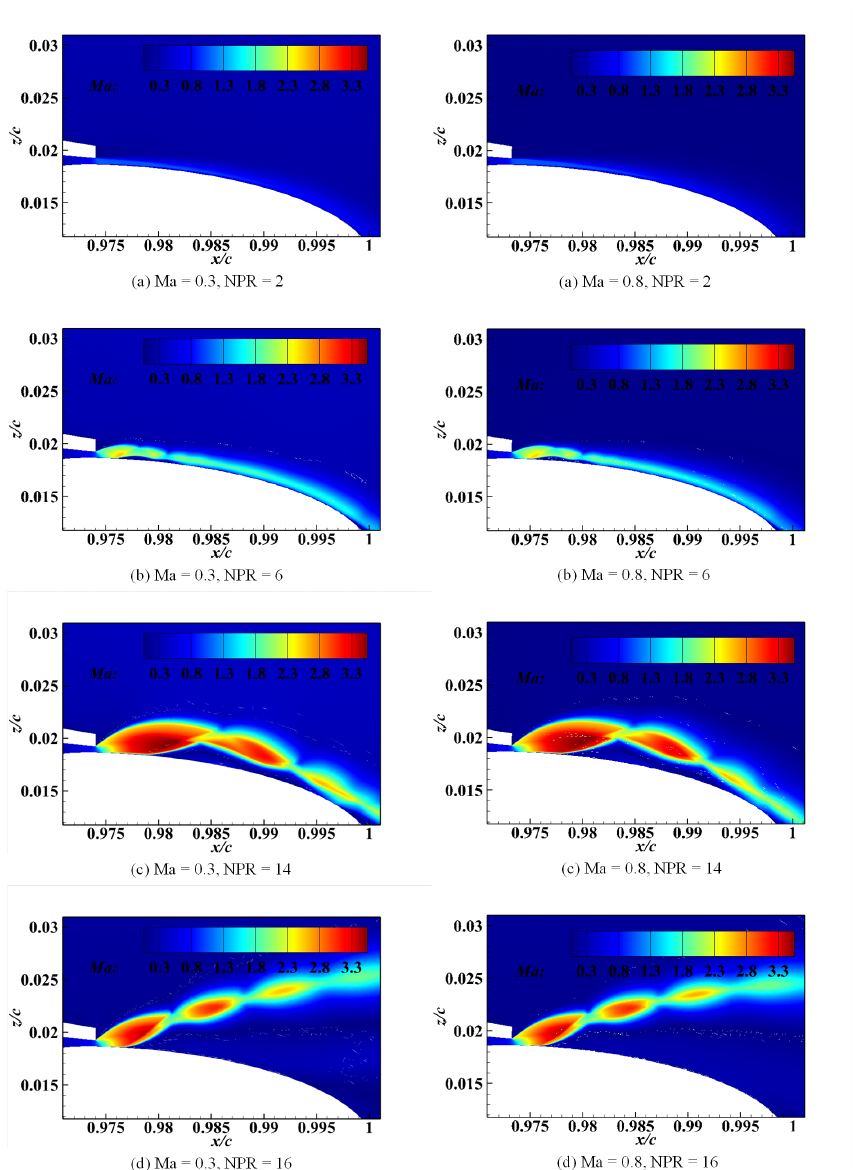
Figure 14. Mach number contours for Ma = 0.3 (left column) and Ma = 0.8 (right column) with α = 3 ◦ to characterize the jet behavior of a supersonic CC jet with increasing NPR ( a ) upon attachment to the reaction surface, ( b ) upon the formation of separation bubbles, ( c ) just before separation, and ( d ) upon full